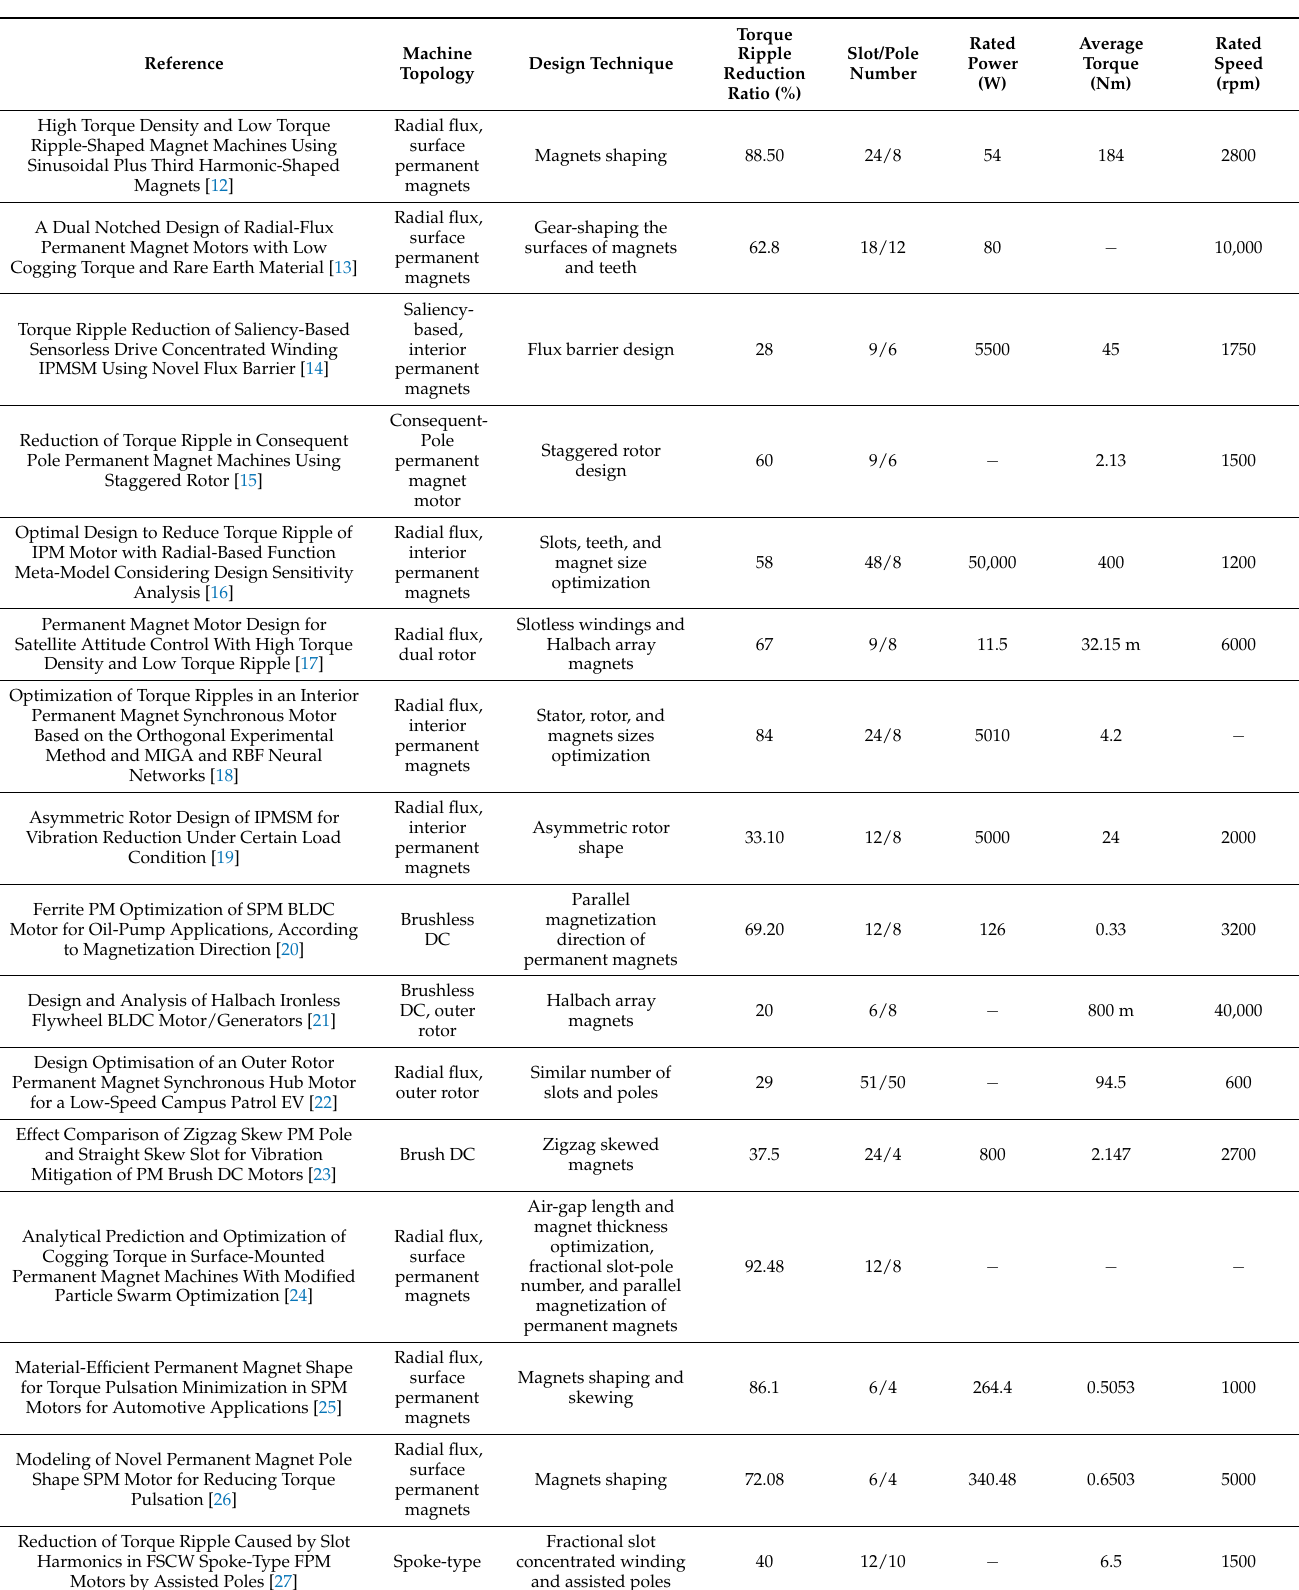
Table 1. Relevant data of the revised torque ripple reduction design